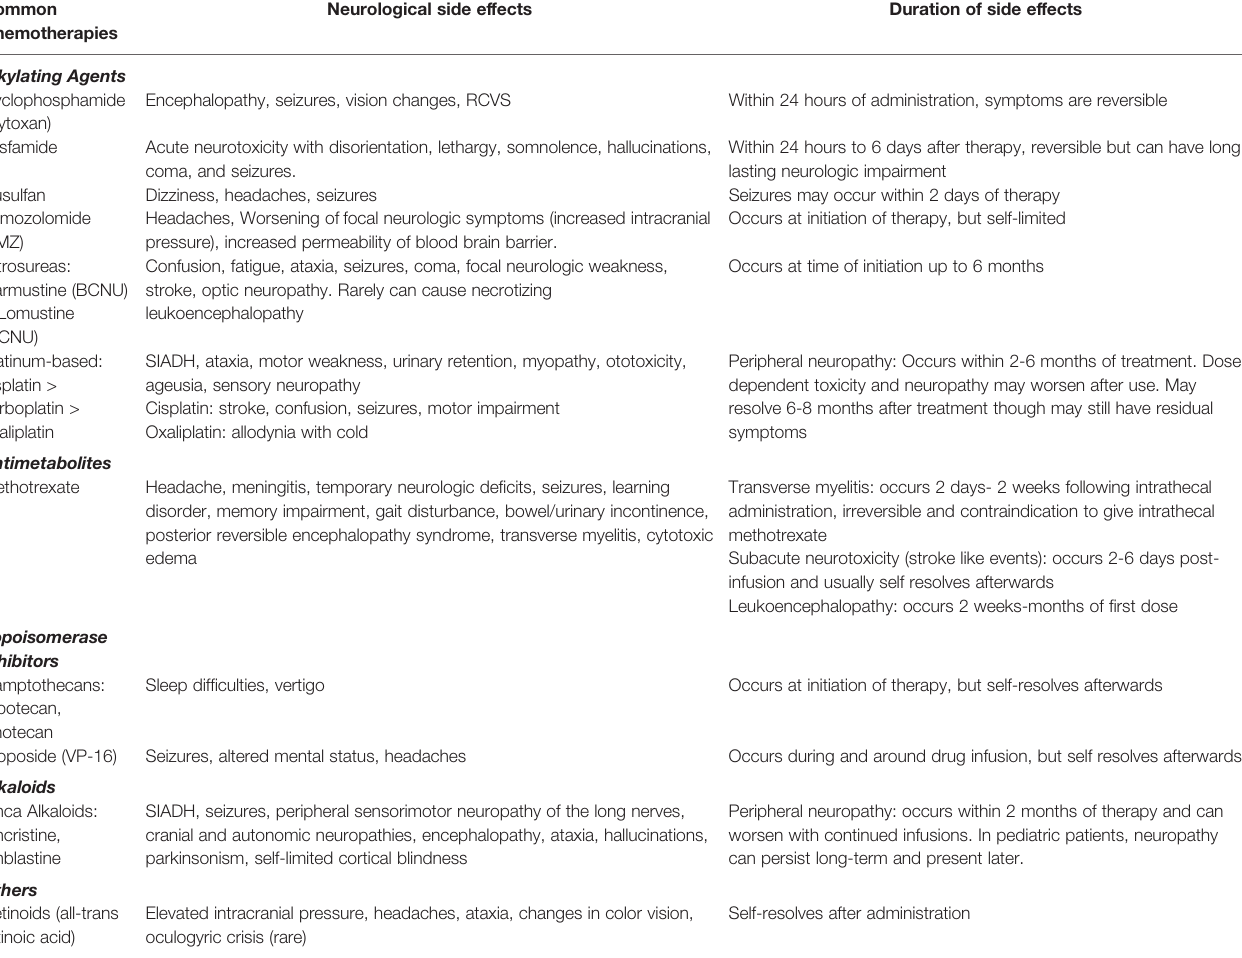
TABLE 1 | Common chemotherapy for brain tumors by mechanism of action and side